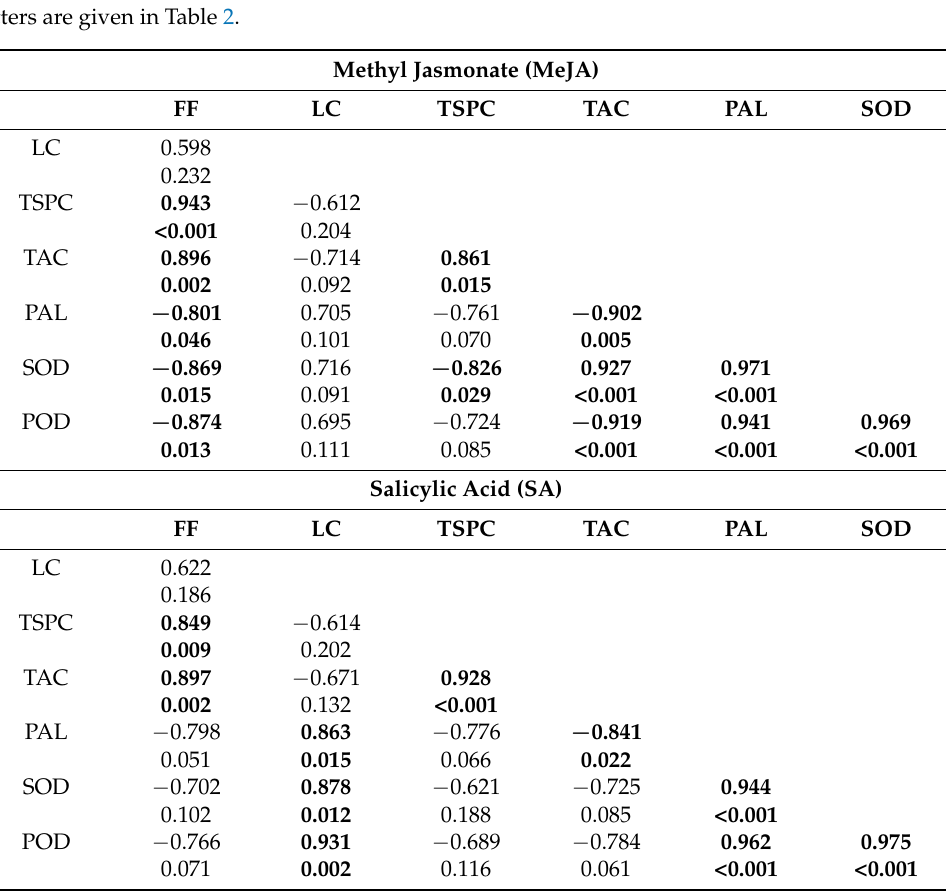
Table 3. Pearson’s correlation coefficients ( r ) and their corresponding significance levels ( P ) amongst 7 fruit measures on apricot cv. ‘Bergarouge’ for non-inoculated fruits with methyl